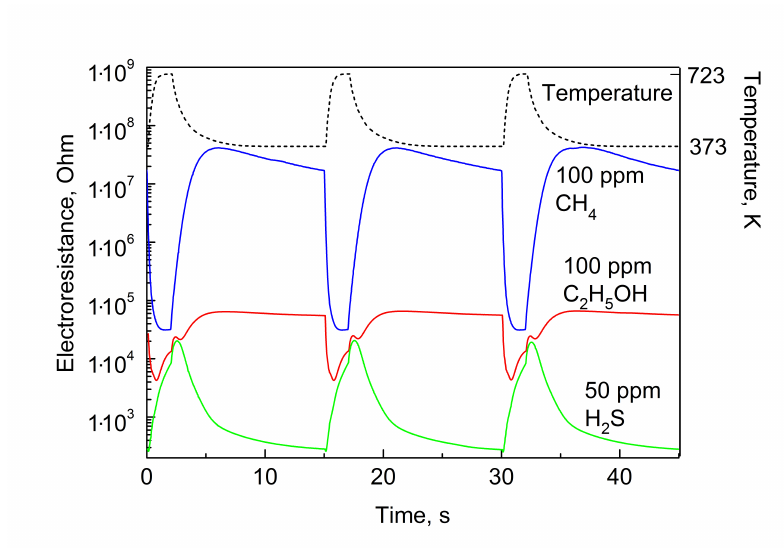
Figure 5. Temperature and electrical resistance of the sensor as a function of time during three measurement cycles at the determination of CH 4 , C 2 H 5 OH and H 2 S concentrations.